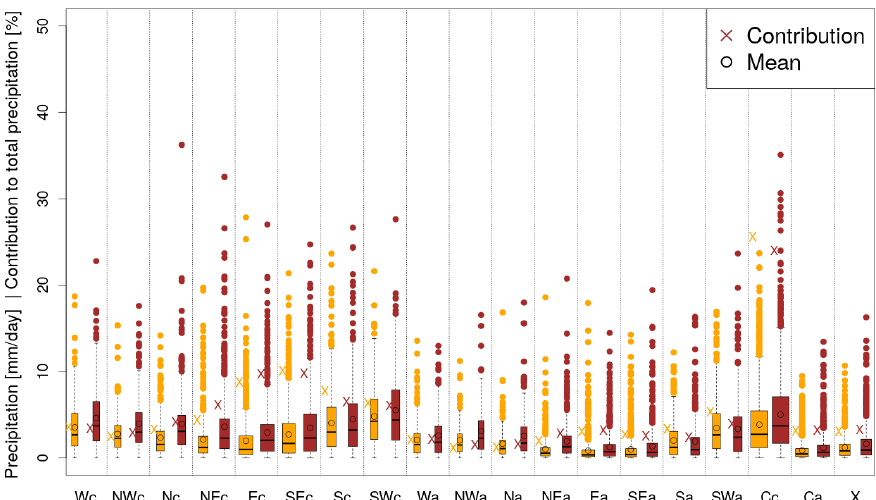
Figure 13. Distributions for current (1971–2000, orange) and future (2071–2100, brown) mean daily precipitation values over Svalbard associated with the different weather types. The crosses denote the contribution to the total precipitation (in %) and the circles the mean precipitation (in mm/day) for each weather type. The horizontal line in the box indicates the median, while bottom and top edges indicate the first and third quartile, respectively. Whiskers extend to the most extreme value which is no more than 1.5 times the interquartile range from the box. Data points outside the whisker range are plotted as outliers. The width of the box indicates the number of